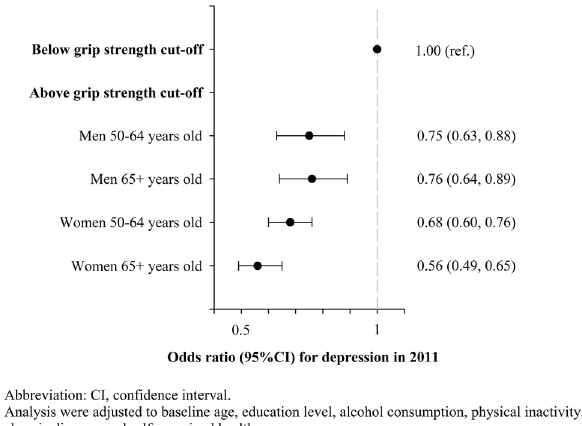
Figure 1. Odds ratio for having depression in 2011 according to being bellow or above the grip strength cut-off value in 2011.